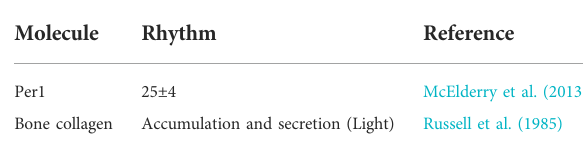
TABLE 1 In vitro bone remodeling markers are rhythmic in